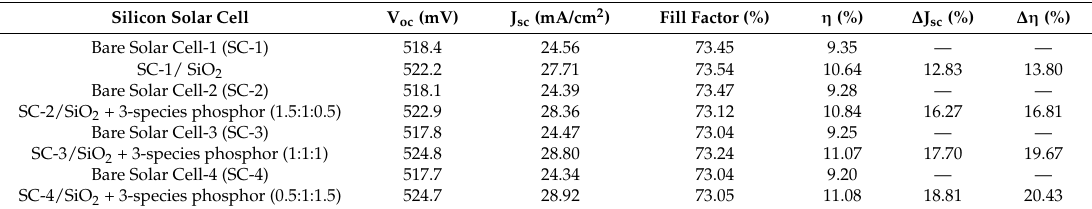
Table 3. Detailed photovoltaic performances of bare solar cell, cell with layer of pure SiO 2 , and cells with SiO 2 layer that includes three species of Eu-doped phosphor at various weight ratios (0.5:1:1.5, or 1:1:1, or 1.5:1:0.5 in wt